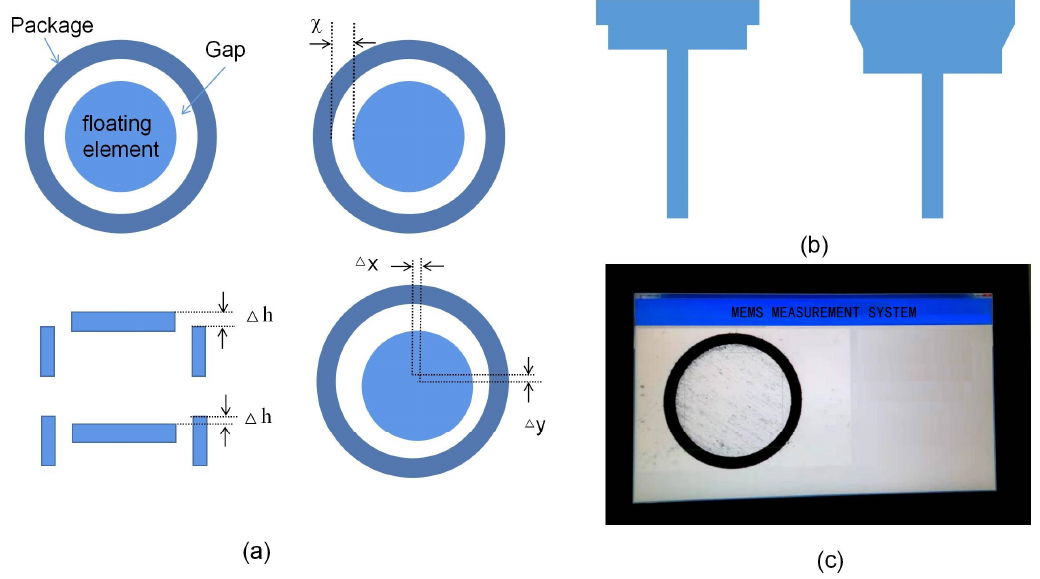
Figure 4. ( a ) The structural error of the prepared sensor; ( b ) the floating element with two-layer structure and three-layer structure; ( c ) the coaxiality measurement of the MEMS sensor.